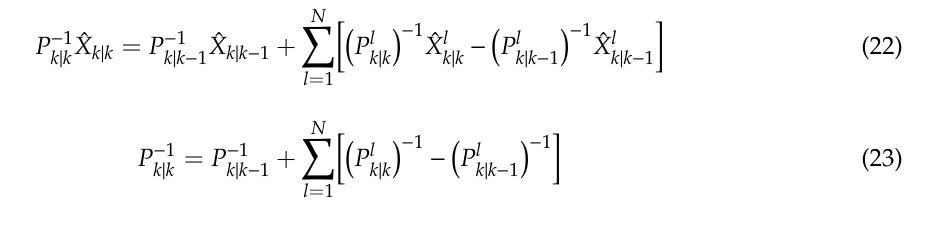
Figure 2. Improved distributed fusion model for single target tracking.